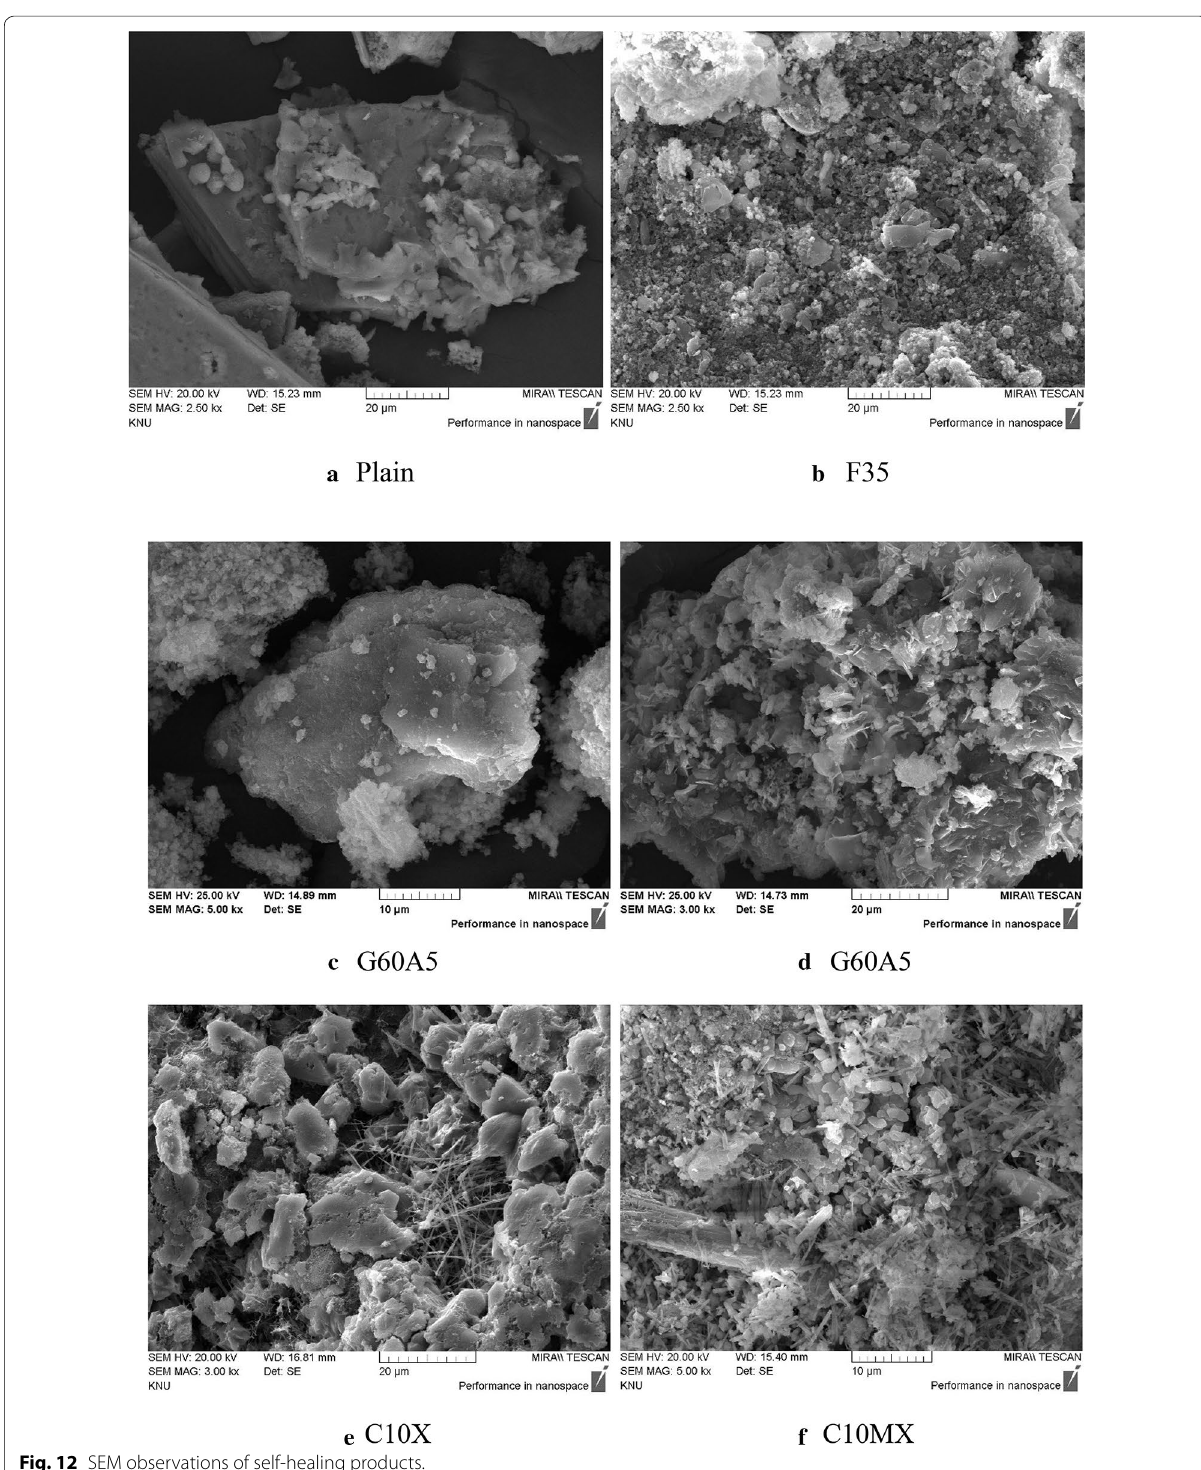
Fig. 12 SEM observations of self-healing